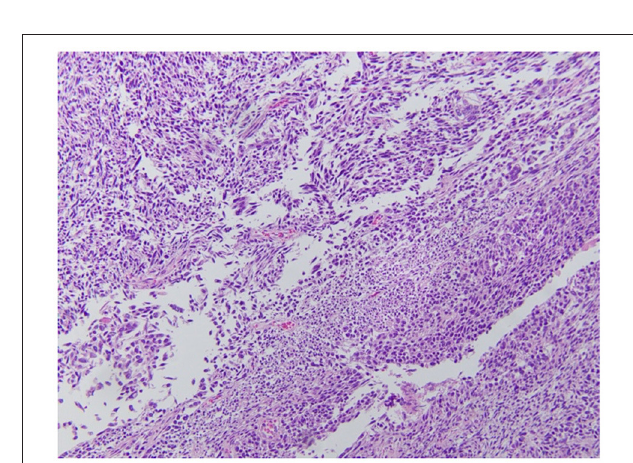
FIGURE 10 | Spindle cell sarcoma component of the tumor.